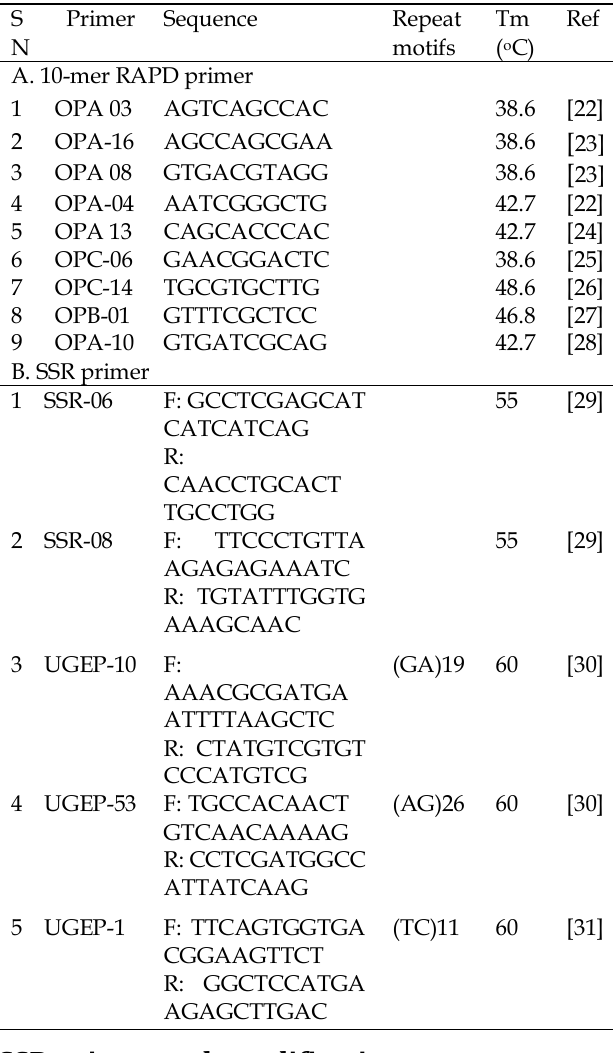
Table 2 . RAPD and SSR primers used in this